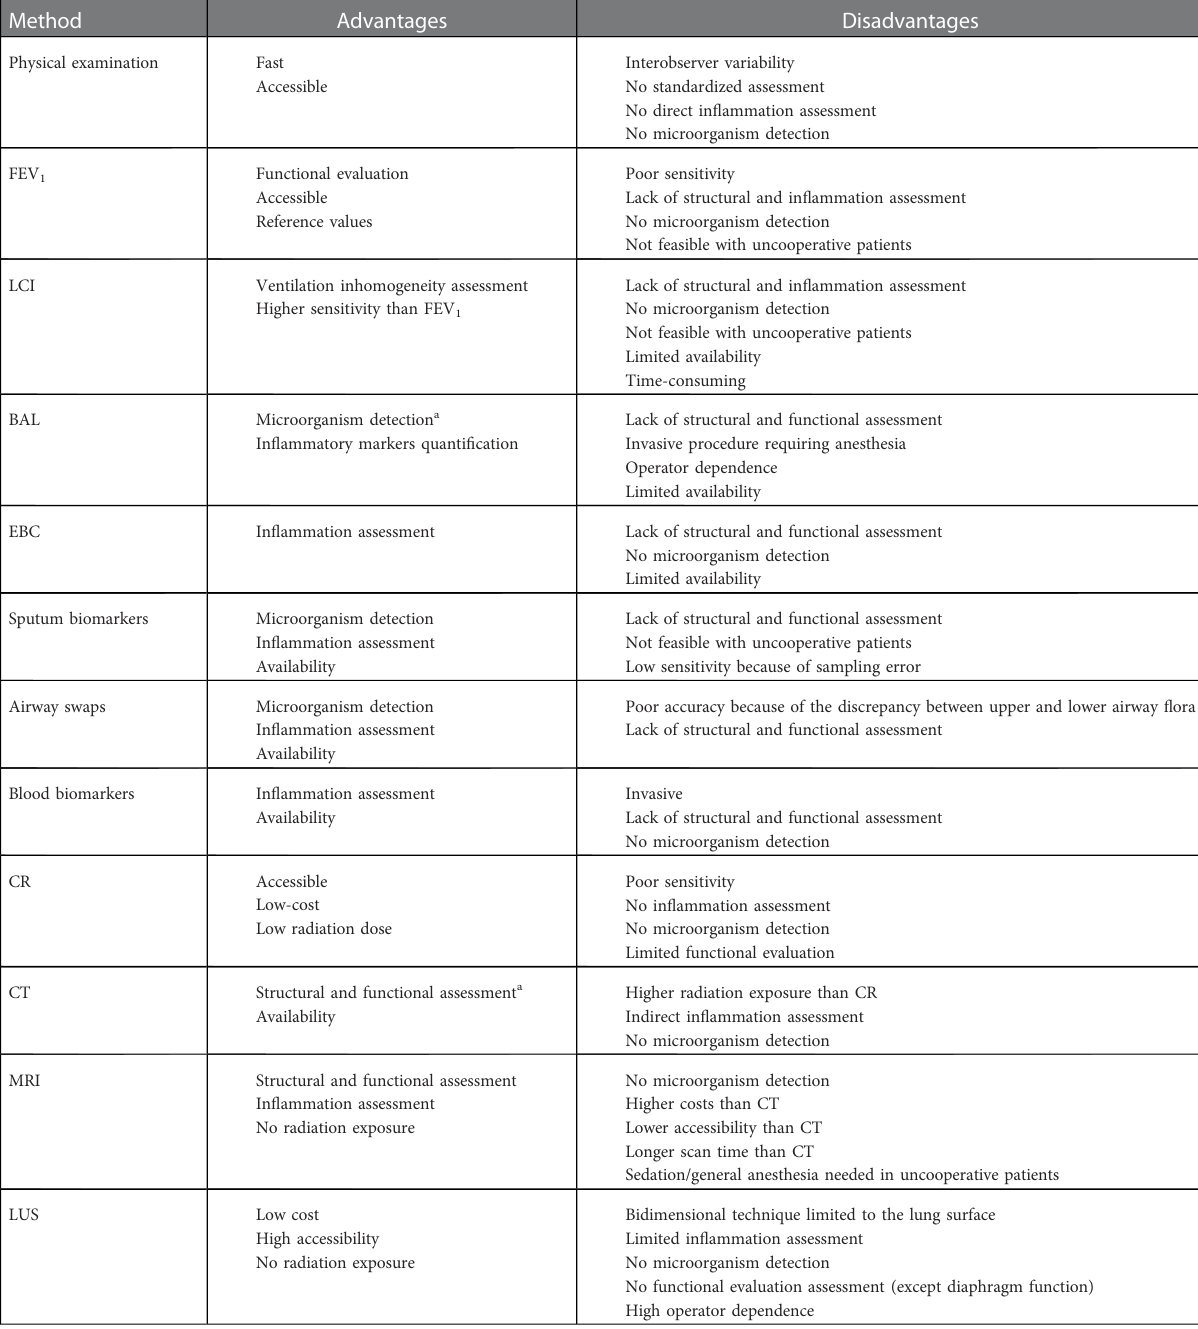
TABLE 3 Advantages and disadvantages for each respiratory tract exacerbation evaluation method.